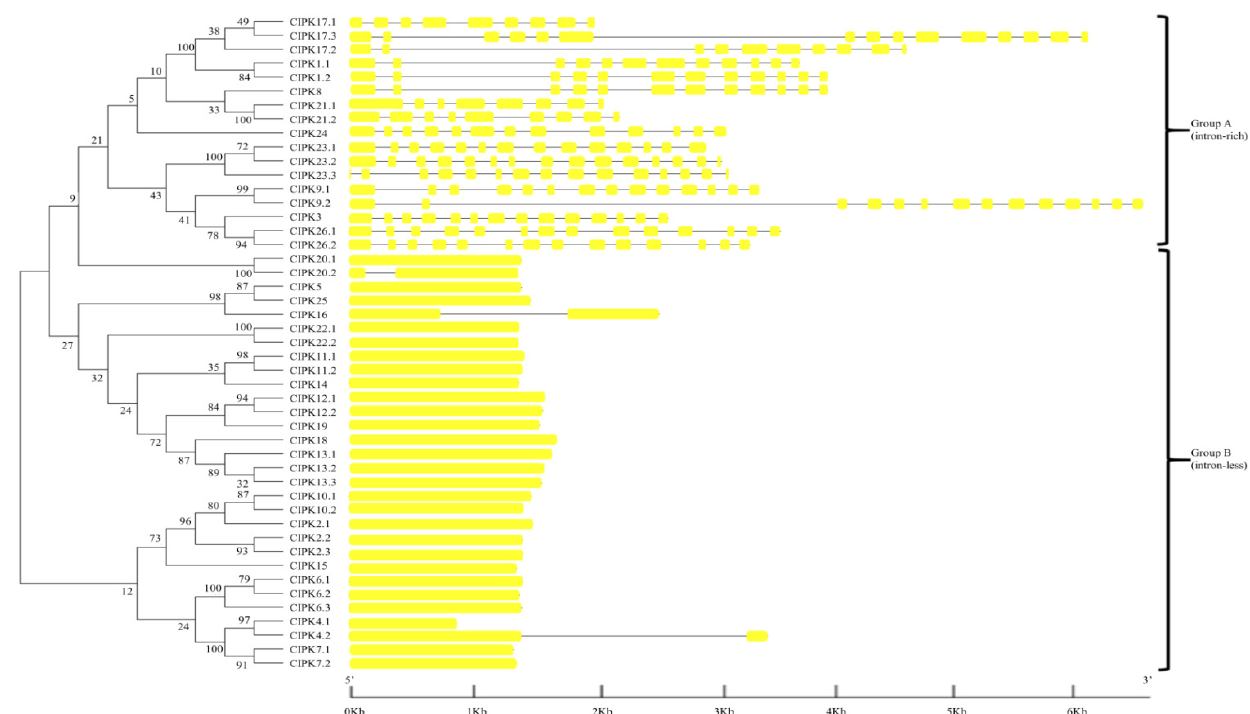
Figure 3. Phylogenetic relationship of Chinese Cabbage CIPK proteins. The BraCIPK protein sequences were aligned using the MAFFT version 7 program, and phylogenetic trees were constructed using the MEGA 7.0 software with the neighbor-joining method and the 1000 bootstrap test replicates. The tree can be divided into three major clades (Group A and Group B).